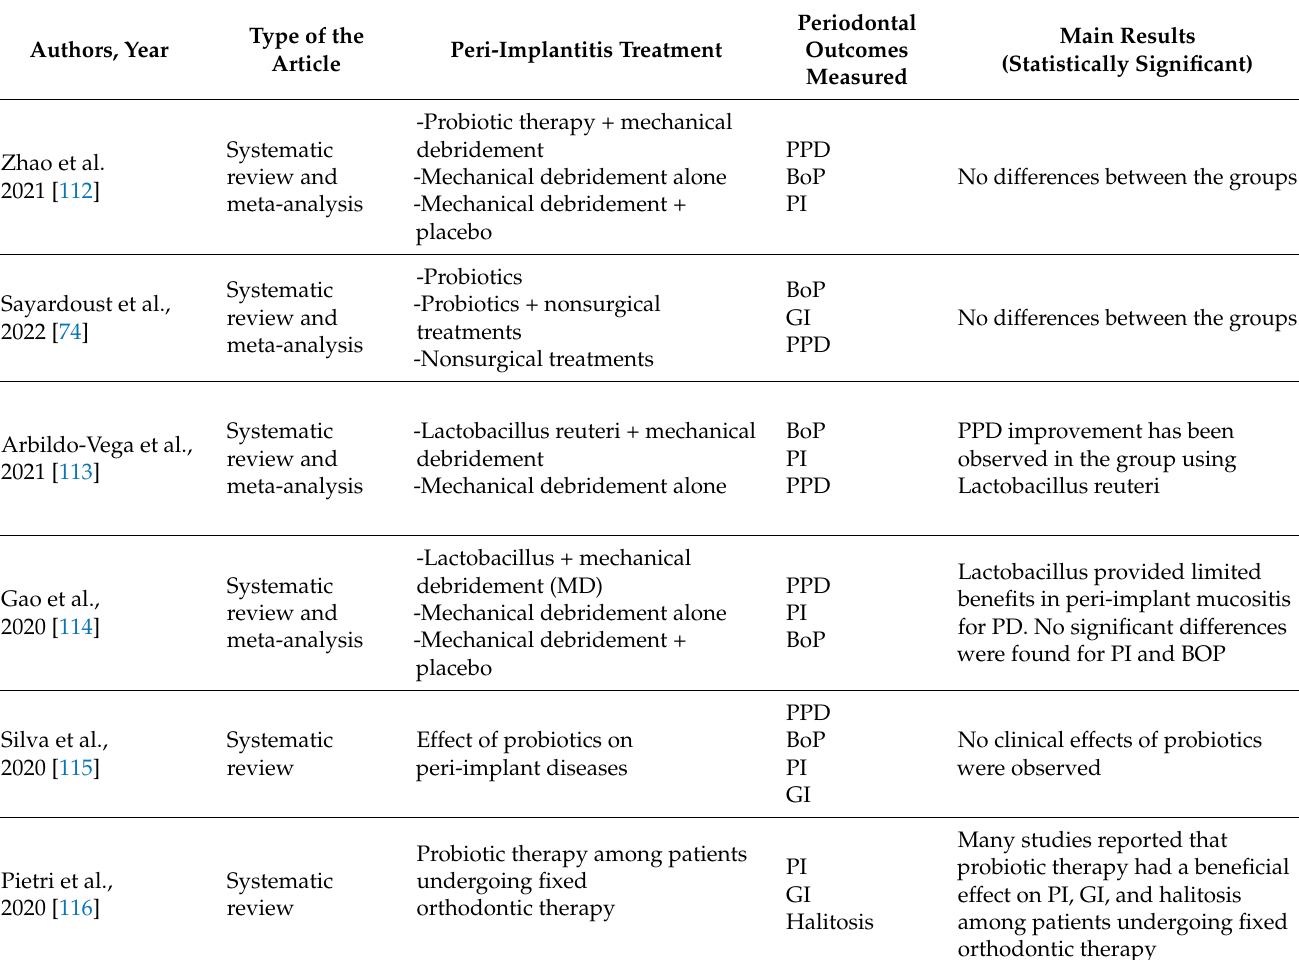
Table 2. Probiotics in peri-implantitis